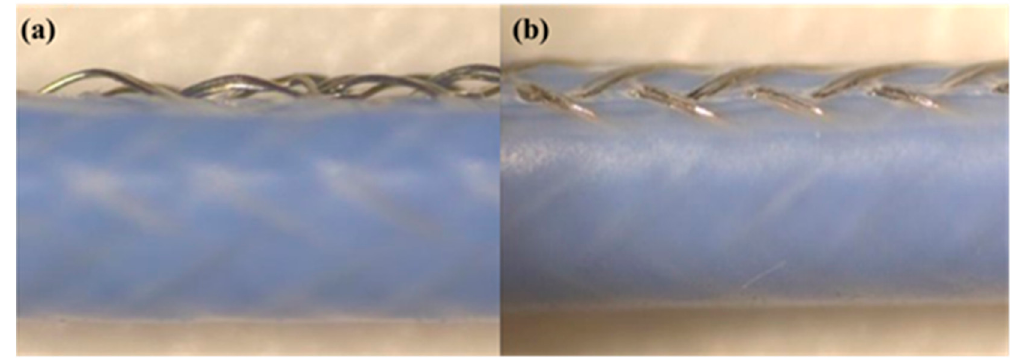
Figure 10. Surface morphology after tension of braid-reinforced composite hollow fiber tube with ( a ) uncoated and ( b ) coated stainless steel wires.